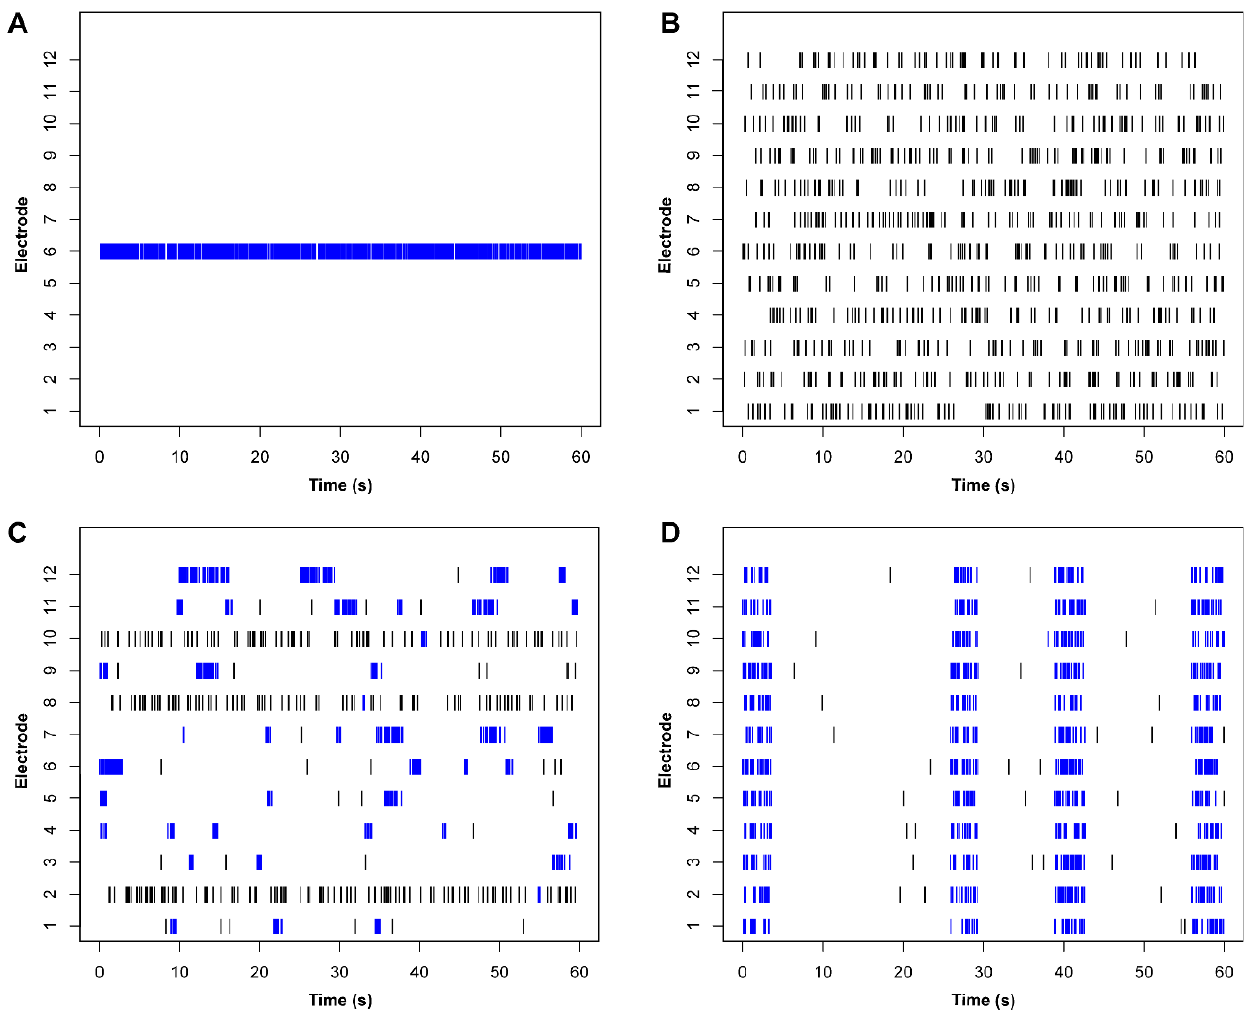
Figure 1. Different spatiotemporal organization of spiking activity in networks with identical mean firing rates. In this didactic example, each figure panel shows a representative raster plot from four hypothetical networks with identical mean firing rates of 20 Hz (1200 spikes in 60 s). ( A ) A network with very little spatial distribution of activity; all 1200 spikes are recorded from a single electrode in the array. ( B ) Spiking activity is well distributed across all 12 electrodes, with activity primarily occurring as loosely organized tonic spiking (black) rather than clustered burst firing (blue). ( C ) A network with a mixture of tonic and burst firing. Low synchronization of bursts across multiple electrodes. ( D ) Spiking activity is highly organized into tightly synchronized network bursts.